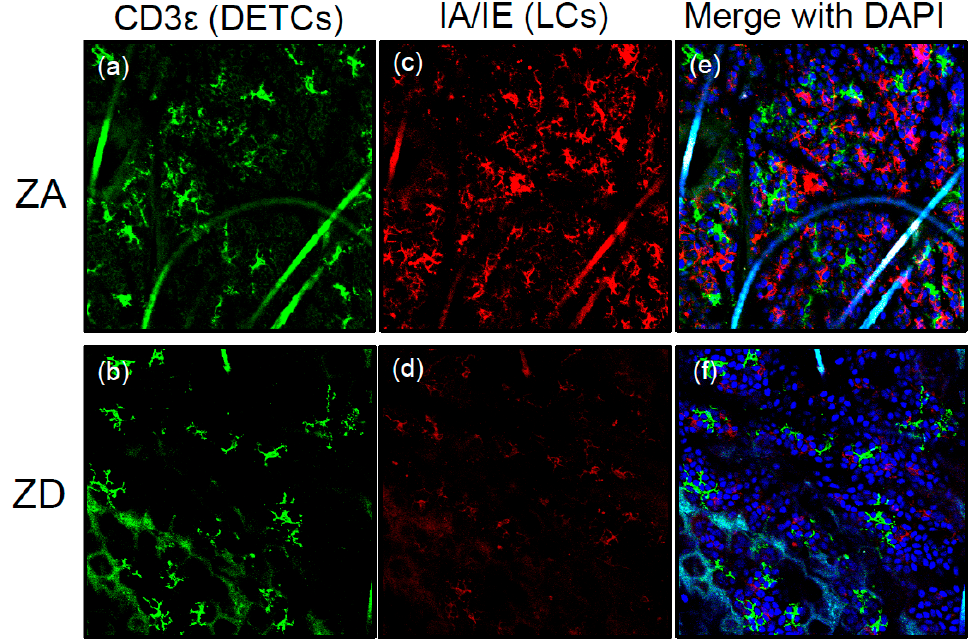
Figure 2. LC loss in ZD ear epidermis. Immunofluorescence of epidermal whole mounts stained for IA/IE (red) and CD3 ε (green) from mice fed ZA or ZD diets for seven weeks. Original magnification, × 100. IA/IE-positive LCs are absent in ZD ear epidermis ( c ) and ( d ); whereas the distribution of CD3 ε -positive dendritic epidermal T cells are unaffected ( a ) and ( b ). ( a ) and ( c ) merge with DAPI is ( e ); ( b ) and ( d ) merge with DAPI is ( f ).